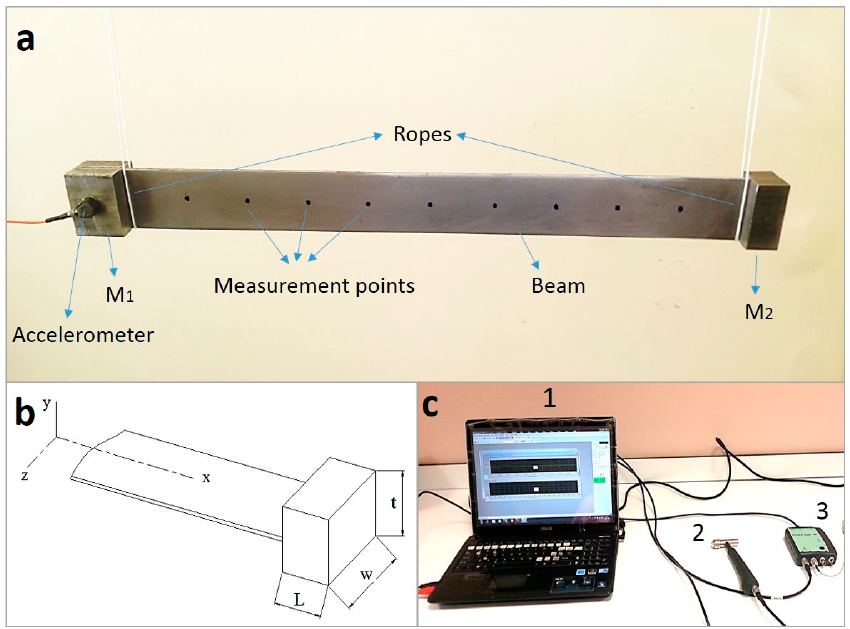
Figure 5. ( a ) Free–free beam with unequal end masses, ( b ) 3D section view of the beam and notations of dimensions ( M 2 ), ( c ) data acquisition system: (1) computer including RT Pro Photon data analysis software; (2) impact hammer; (3) photon+ data acquisition card. Table 3. The physical properties of beam and tip